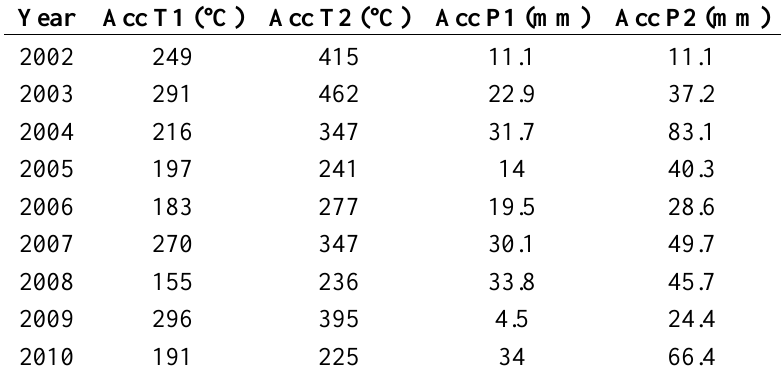
Table 1. Accumulated values of air temperature and precipitation during the third decade of April (Acc T1, Acc P1) and the first decade of May (Acc T2, Acc P2) for the years